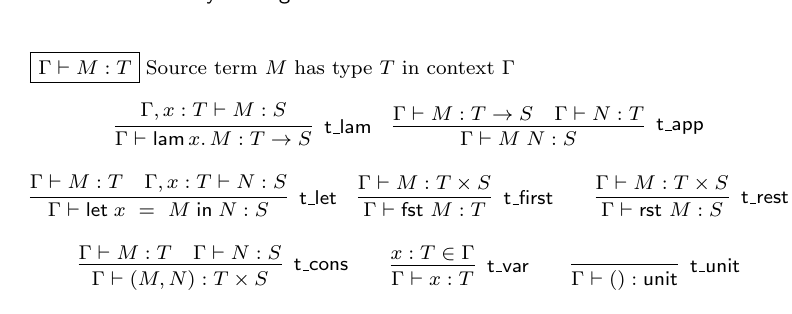
Fig. 2. Typing rules for the source